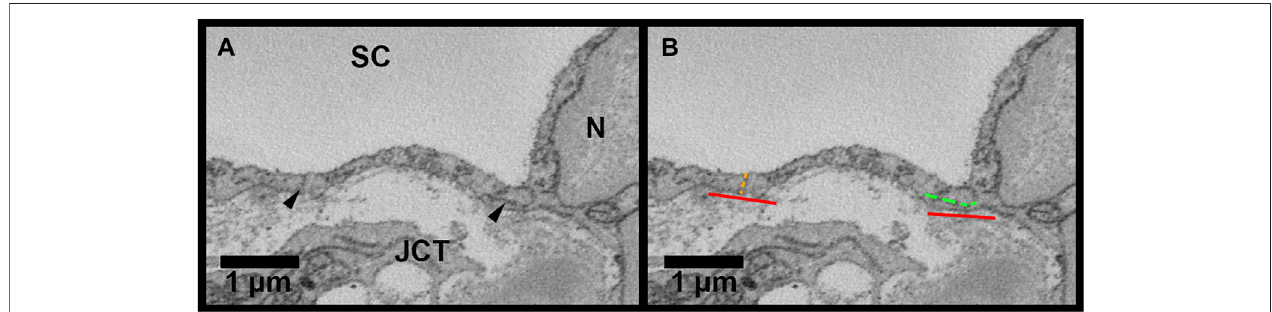
FIGURE 4 | Methods for inner wall cell overlap length measurements in Reconstruct. (A) : Inner wall cell overlap length (OL) was measured on both sides of the reconstructedcellsonevery40sectionsthroughoutthelengthofeachcell.Thejunctionsbetweenthecellanditsadjacentcellsaredemarcatedwith arrowheads . (B) :To measureOL,alineparalleltotheinnerwall(IW)wasdrawn fi rst( redlines ).OLwasmeasured iftheplaneofoverlap wasparalleltotheaxisoftheinner wallorwithin45 ° of the IW axis (example shown by the segmented green line on the right of the cell). An example of no overlap length (OL = 0 µm) is shown on the left of the cell ( segmented orange line ). JCT = juxtacanalicular connective tissue; SC = Schlemm ’ s canal; N = inner wall endothelial cell nucleus.